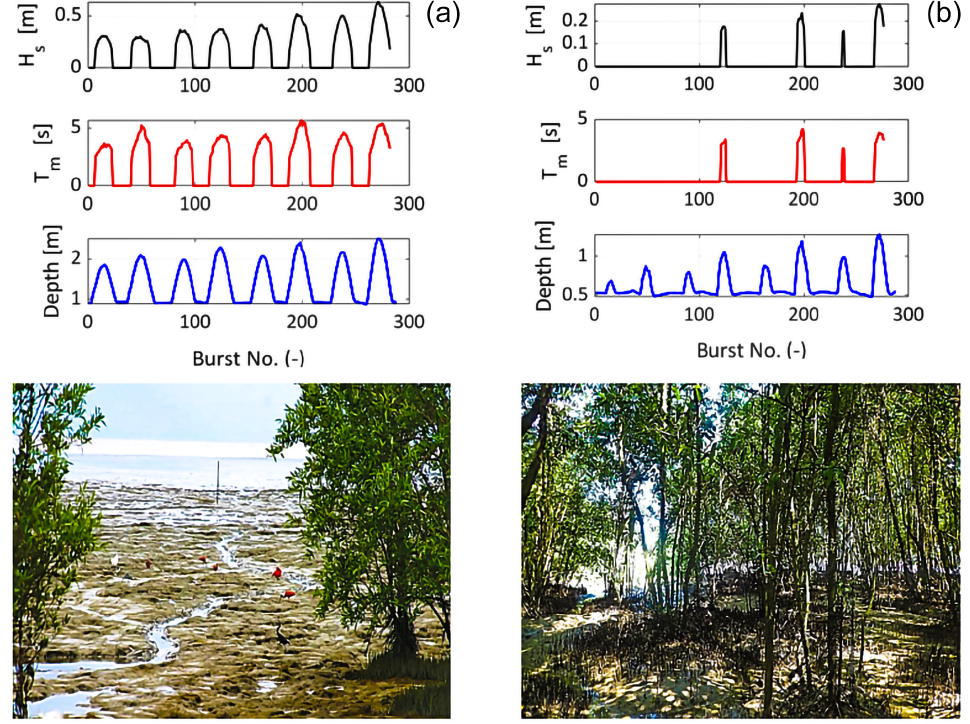
Figure 12. Wave heights, wave periods and water depths at (a) a location at approximately 40% of the fringe width and (b) 1.6km offshore and along the Chateau Margot coast,